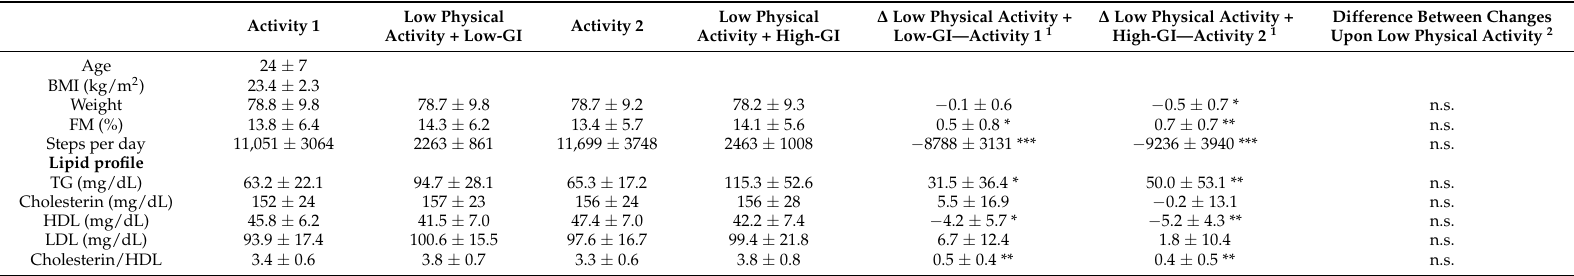
Table 1. Basal characteristics and low physical activity-induced changes of body weight, fat mass and cardiovascular risk factors stratified by low-GI vs. high-GI SSB intervention, n = 13.